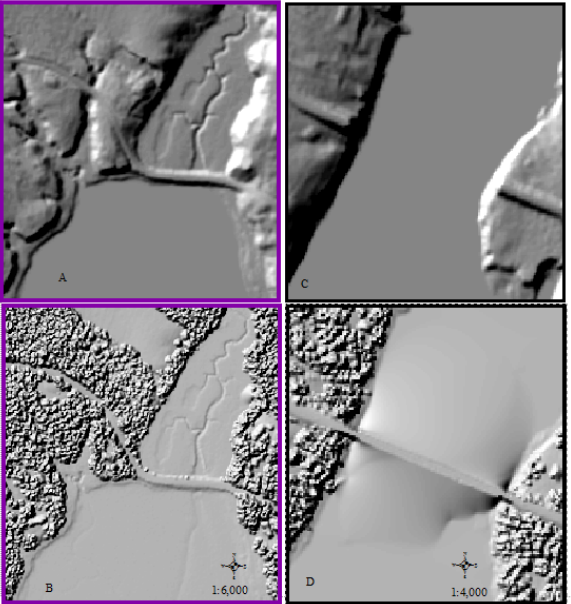
Figure 3 – Inundated road sections with Digital Terrain Model and Digital Surface